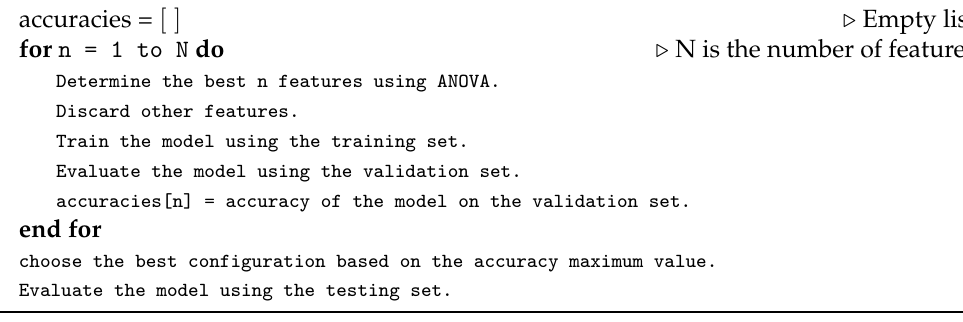
Algorithm 1 Basic steps for determining the best training settings for the model using ANOVA.